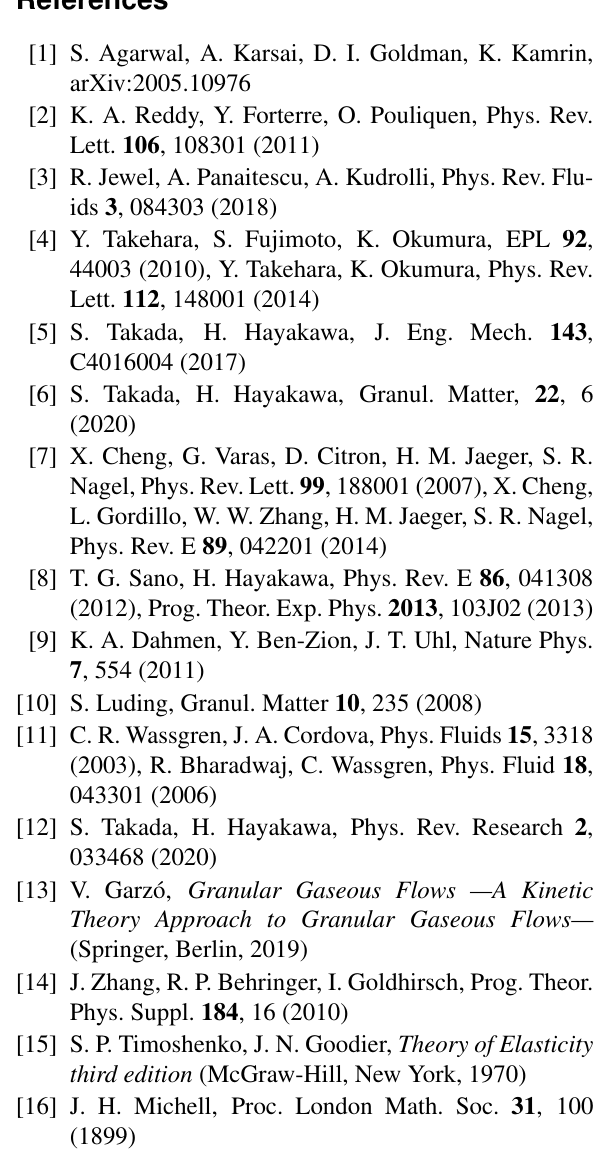
√ ≡ v k n / m ) 0 , x / ( d 0 , x